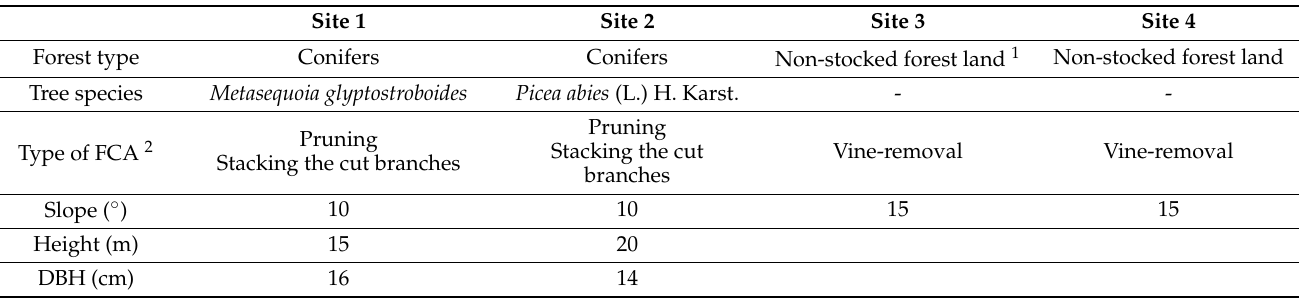
Table 1. The characteristics of the experimental